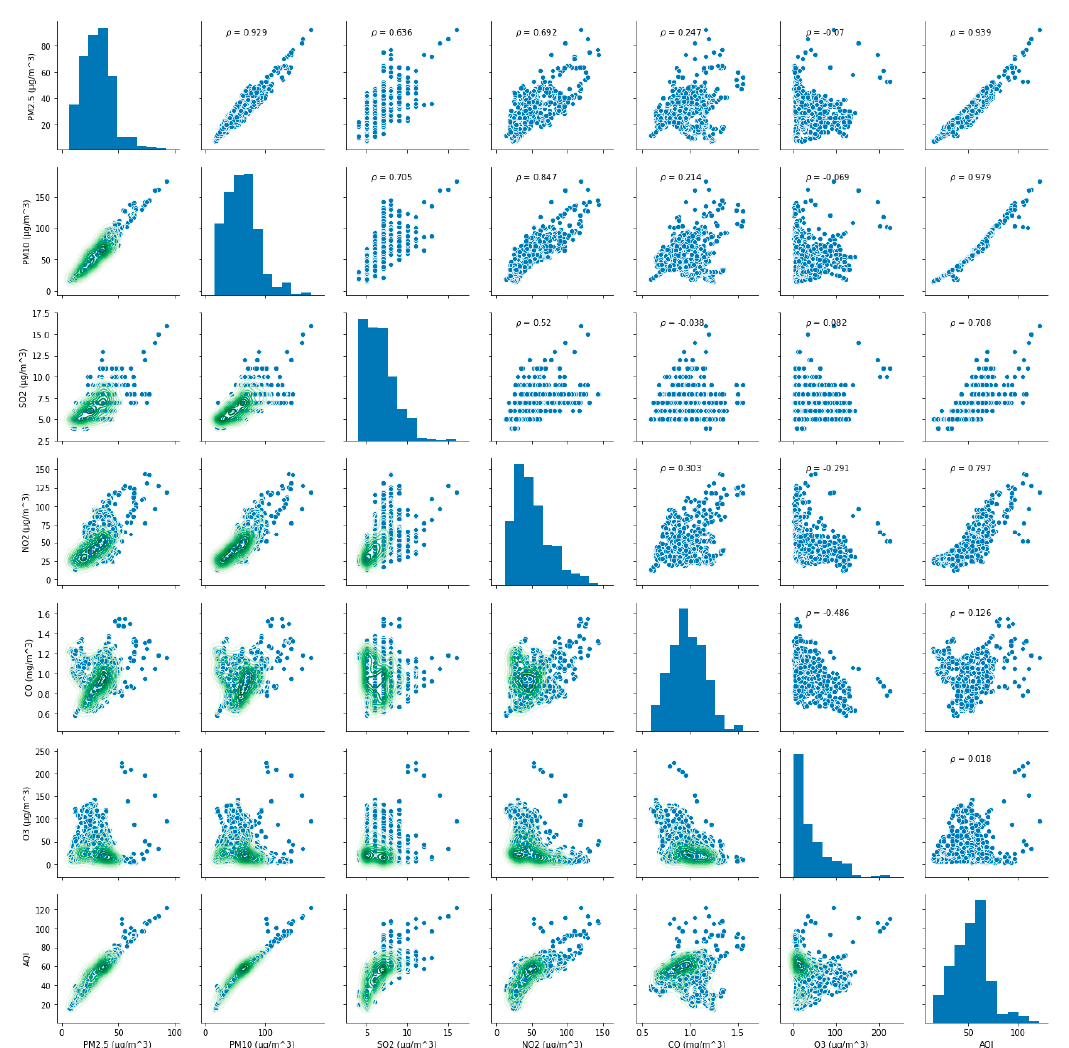
Figure 3. The correlation relationship between Air Quality Index (AQI) and six pollutants in case one.